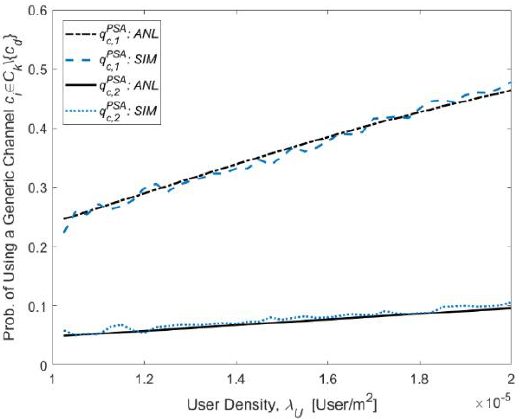
Figure 10. The 𝑞 𝑐,𝑘PSA in the underlay in-band D2D mode vs. the density of users when the PSA policy is used.